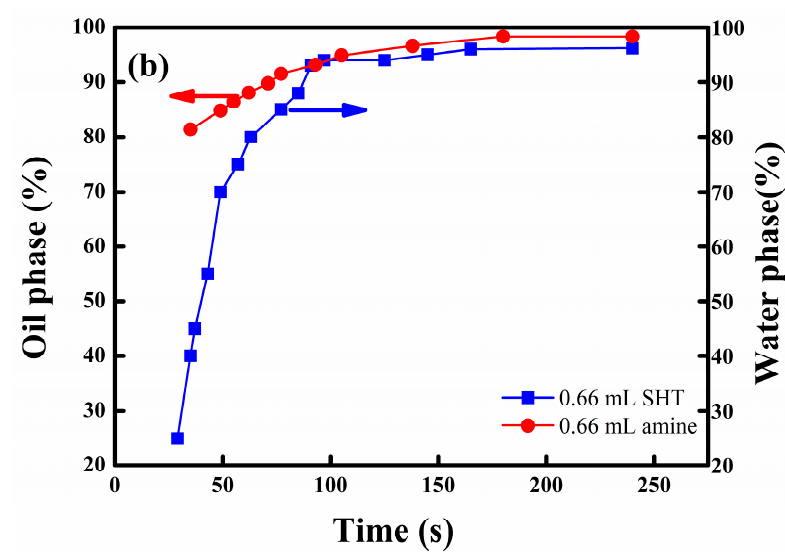
Figure 6. The effect of ( a ) asphaltene (1.7 g/L) and SHT content SHT (11%); ( b ) SHT (2.2%) (without asphaltenes) and Et 3 N (2.2 %) (without asphaltenes) on the stability of maltenes-in-water emulsions.